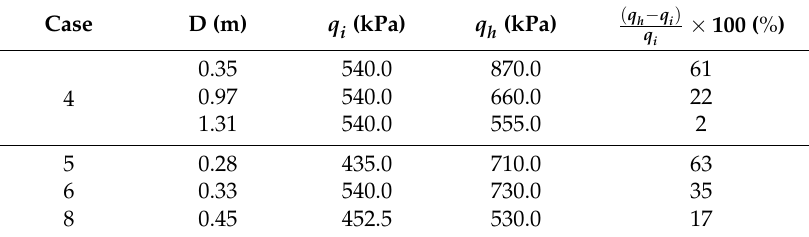
Table 3. The variation of the average tip resistance due to ground heating using an electric heat pipe. Case